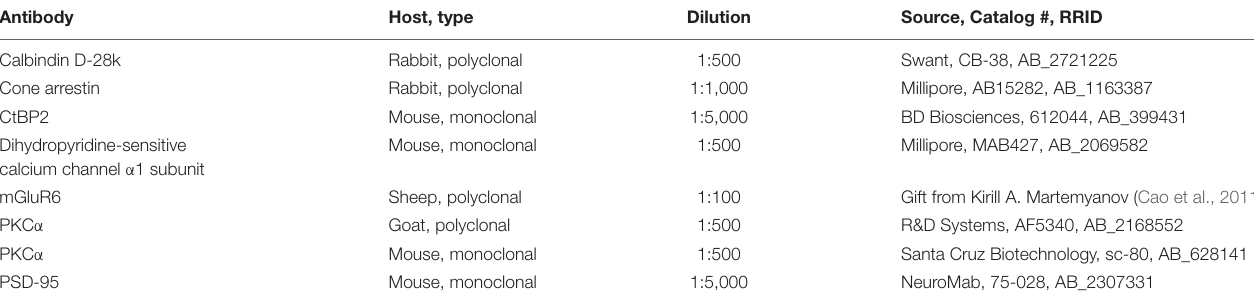
TABLE 1 | List of primary antibodies used in this study. Antibody Host, type Dilution Source, Catalog #, RRID Calbindin D-28k Rabbit, polyclonal Cone